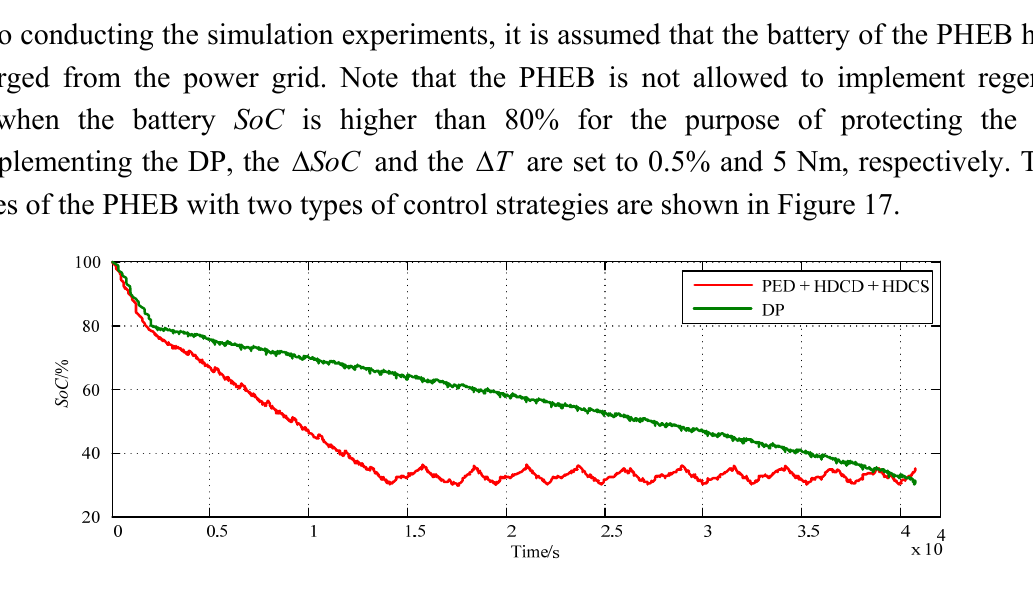
Figure 17. The SoC trajectories under two types of